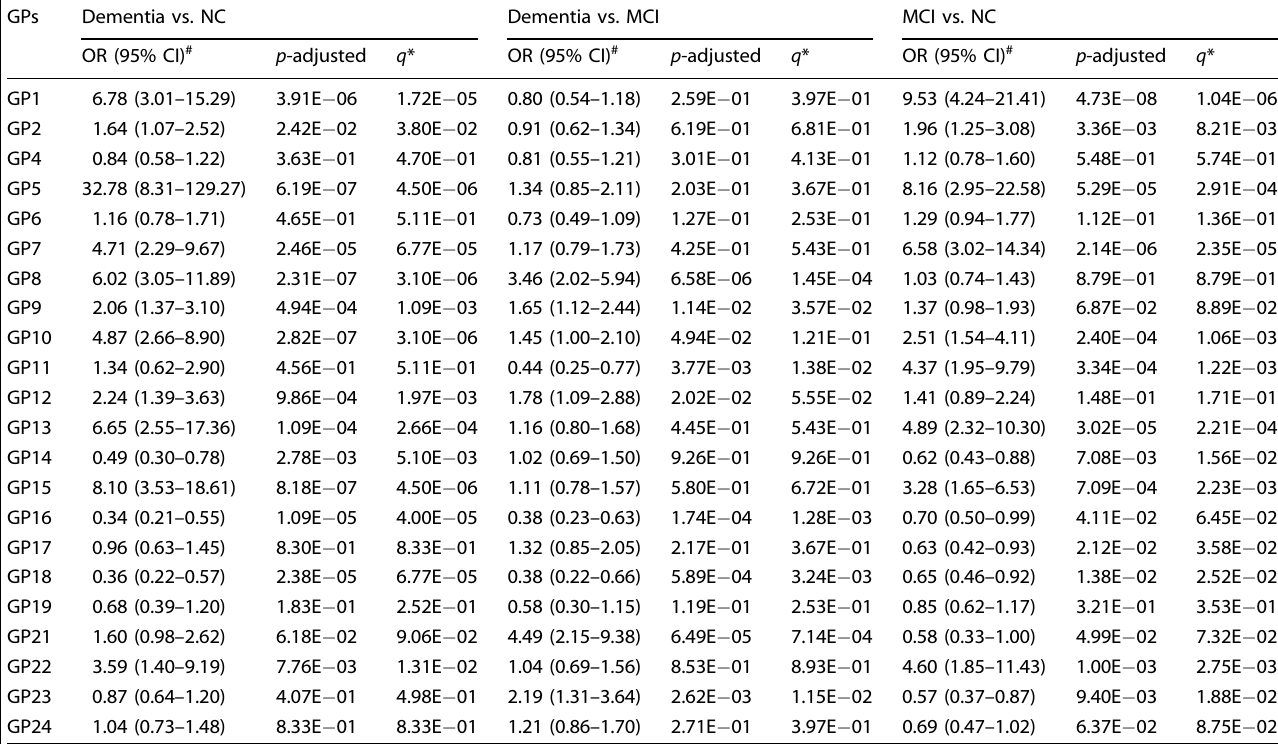
Table 3. Associations of the normalized initial glycans. GPs Dementia vs.